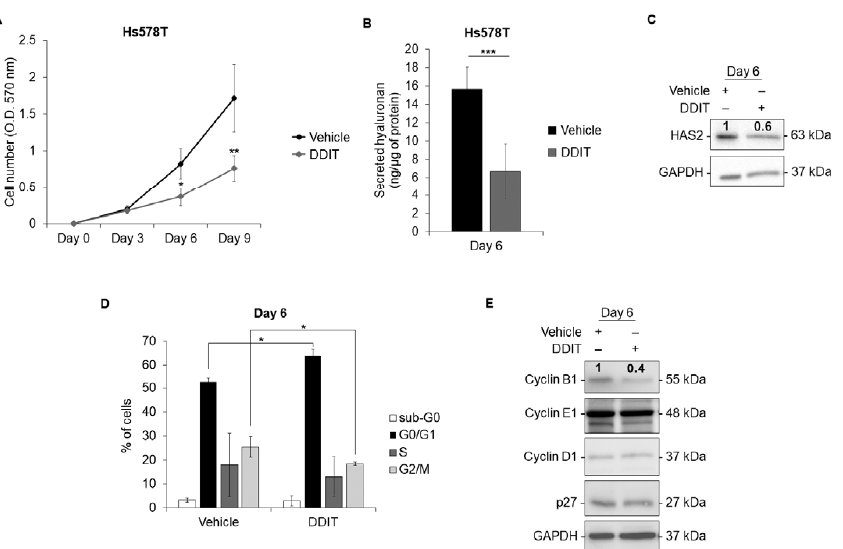
Figure 8. DDIT blocks cell cycle progression and inhibits breast cancer cell proliferation. ( A , B , D ) Proliferation of Hs578T breast cancer cells after treatment with vehicle (0.04% DMSO) or DDIT (80 μ M) for 3, 6 and 9 days, in medium containing 10% FBS ( A ), hyaluronan secreted by Hs578T cells at day 6 ( B ), and analysis of Hs578T cell cycle progression with flow cytometry at day 6 ( D ). ( C , E ) Immunoblotting of HAS2 and GAPDH ( C ) and of cyclin B1, cyclin E1, cyclin D1, p27 and GAPDH ( E ) in total cell lysates of Hs578T, after treatment with vehicle or DDIT for 6 days, in medium con- taining 10% FBS. Statistical significance is depicted as asterisks (*, p < 0.05; **, p < 0.01; ***, p < 0.001). Original blots see Figure